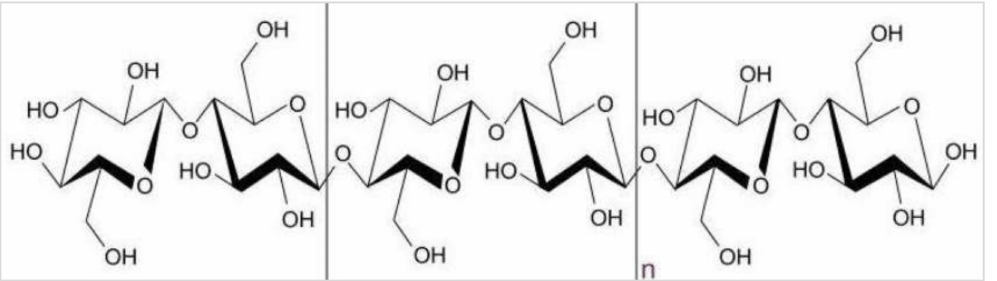
Figure 10. Cellulose structure, i.e., β -D-glucopyranose interlinked with (1–4) glycosidic bonds in a polymer